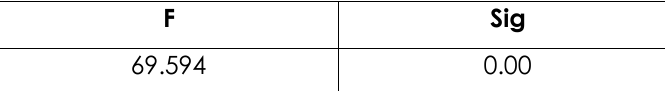
Table 4. ANOVA Table of Hypothesis